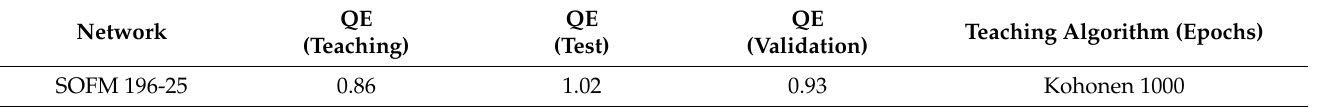
Table 4. Results of the training process of SOM network with 25 output neurons.